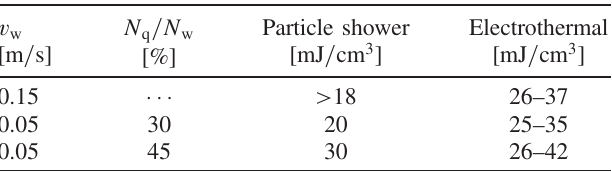
TABLE III. Quench-level comparison; FLUKA estimate and electrothermal MQED estimate in the MBRB coil for the wire- scanner quench test. Lower values in electrothermal estimates correspond to a reduced cooling model; upper values correspond to the standard cooling